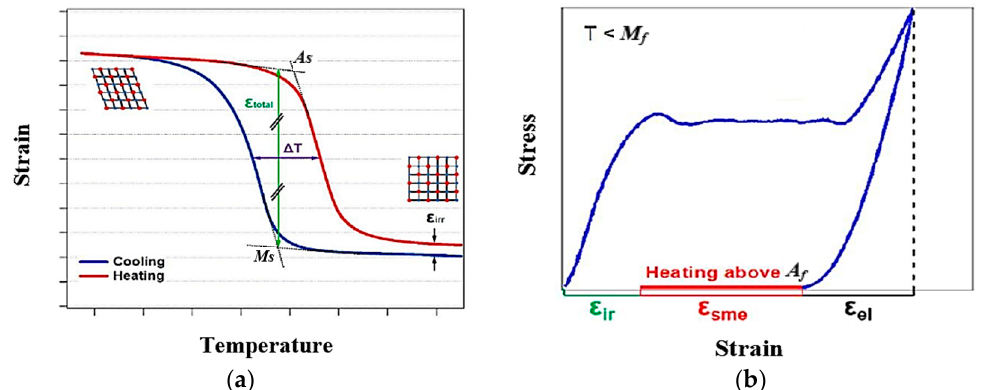
Figure 2. ( a ) Representation of phase transformation in shape memory Ni-Ti [40], and ( b ) Stress- Strain-Temperature graph showing phase transformation in Ni-Ti [41].